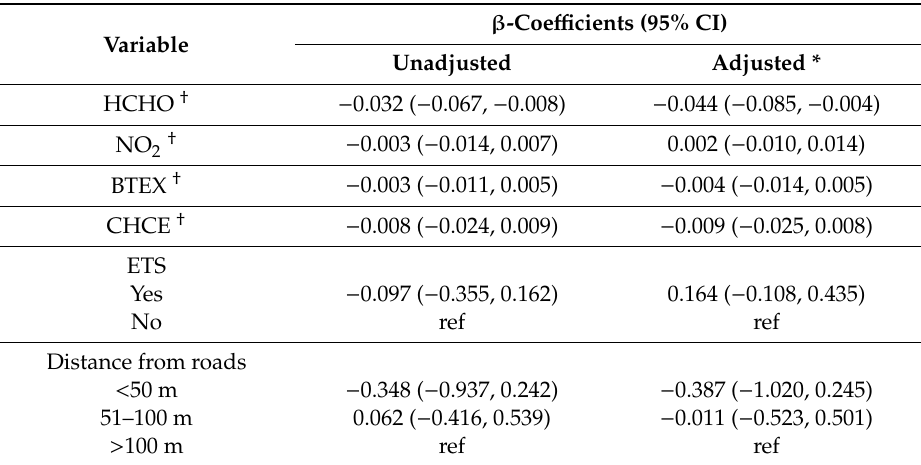
Table 3. Associations between environmental exposures and birth weight. β -Coe ffi cients (95% CI) Variable Unadjusted Adjusted